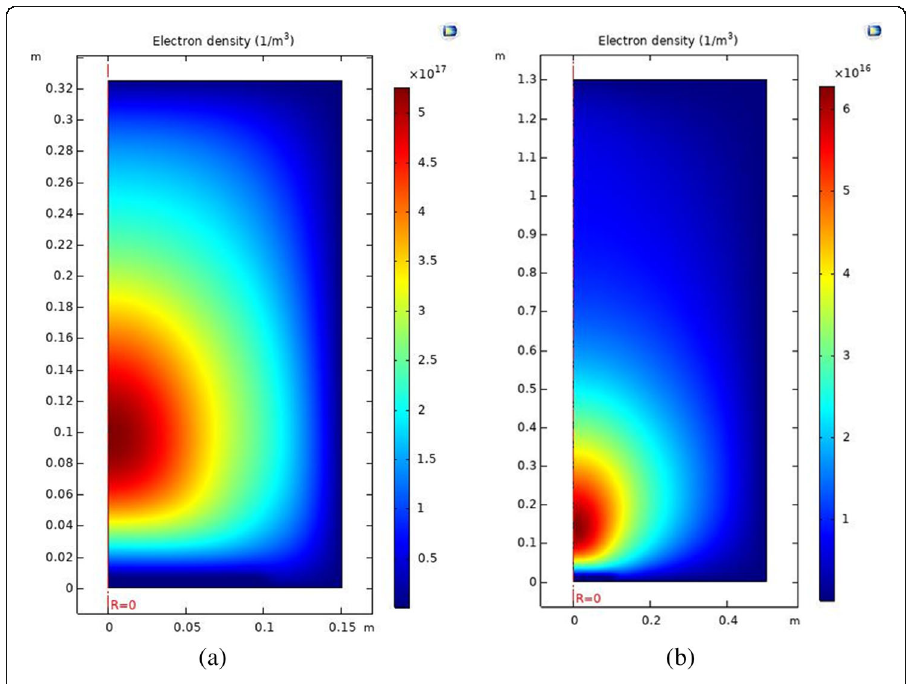
Fig. 9 Simulated electron densities under 6 Pa environmental pressure, with 1 kV DC excitation power for spans of ( a ) 0.32 m and ( b ) 1.3